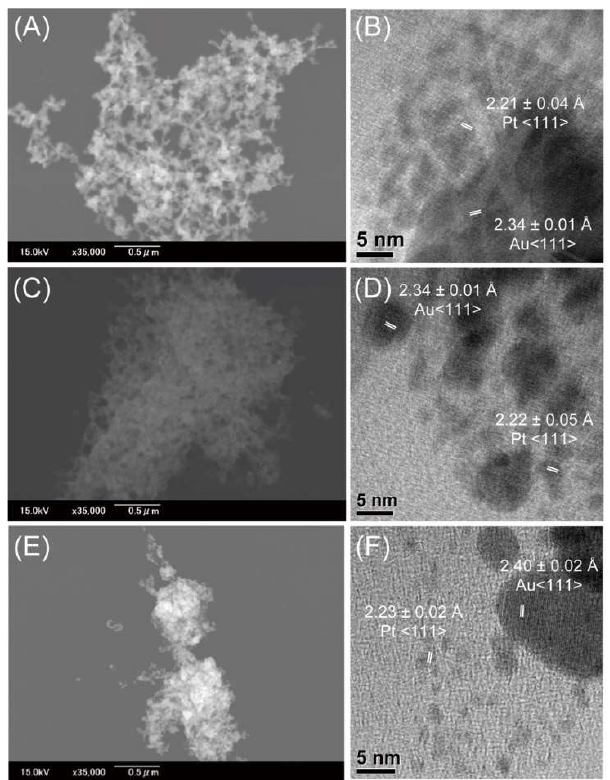
Figure 3. Field emission-scanning electron microscopy (FE-SEM) ( A , C , E ) and transmission electron microscopy (TEM) ( B , D , F ) images of precipitates from reaction mixtures of peptides (( A , B ) RU006, ( C , D ) (NaI 2 )-RU006 and ( E , F ) (Ant 6 )-RU006) and metal ions (HAuCl 4 and H 2 PtCl 6 ). (Peptide) = 2.0 × 10 −4 M and (HAuCl 4 ) = (H 2 PtCl 6 ) = 5.0 × 10 −5 M in water. Each reaction was conducted at 40 °C for 24 h in the